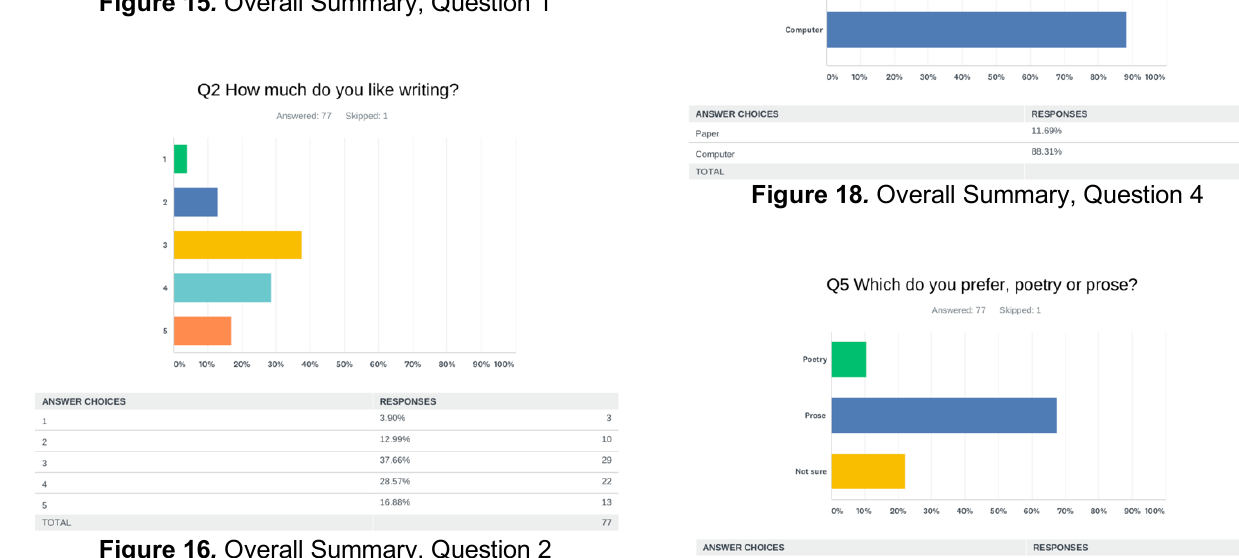
Figure 15 . Overall Summary, Question 1